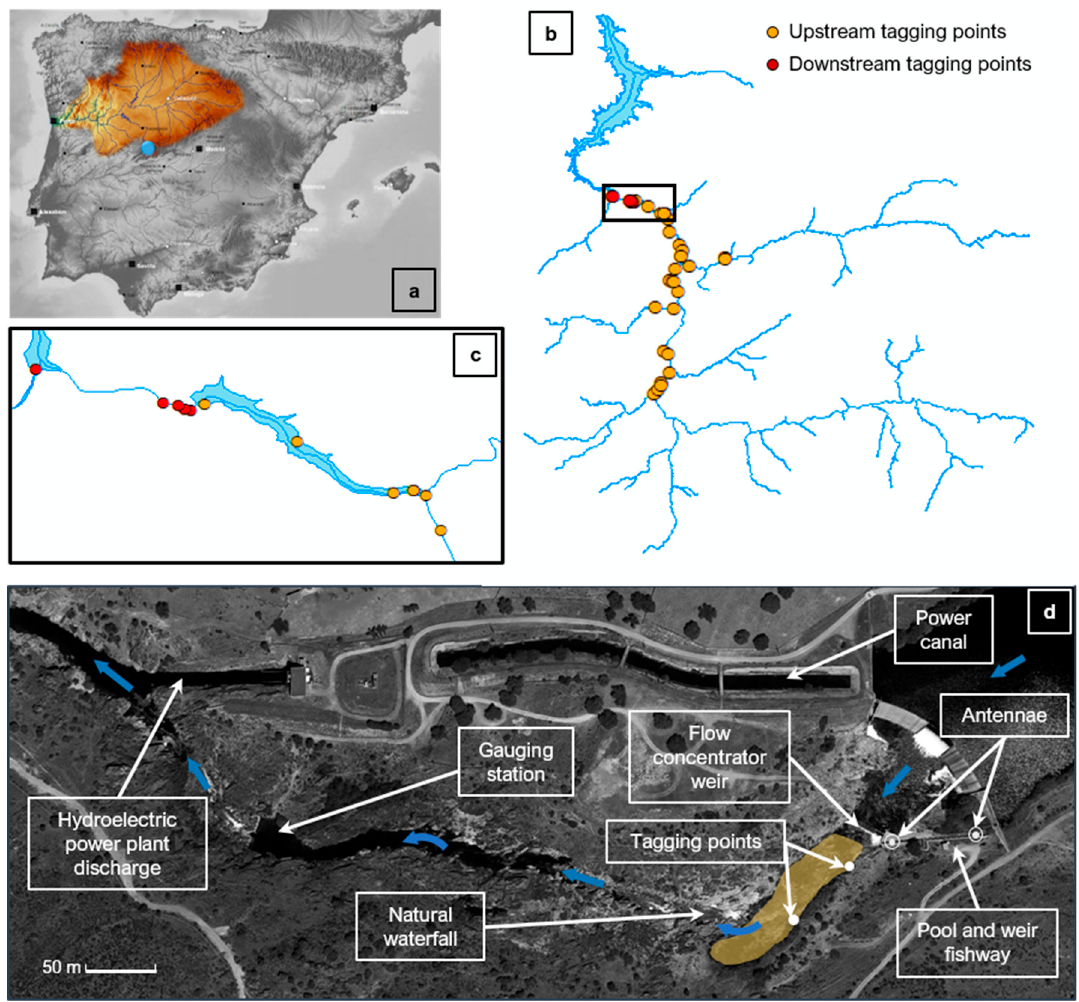
Figure 5. General view of the study area. ( a ) Location of Duero basin and Tormes river in the Iberian Peninsula (adapted from Port(u*o)s [CC BY-SA 3.0 (https://creativecommons.org/licenses/by-sa/3.0)]); ( b ) location of tagging points in the basin; ( c ) location of tagging points in the vicinity of the dam, and ( d ) satellite view of the study site. Blue arrows indicate flow river direction; yellow area indicates the electrofishing area just downstream the fishway.